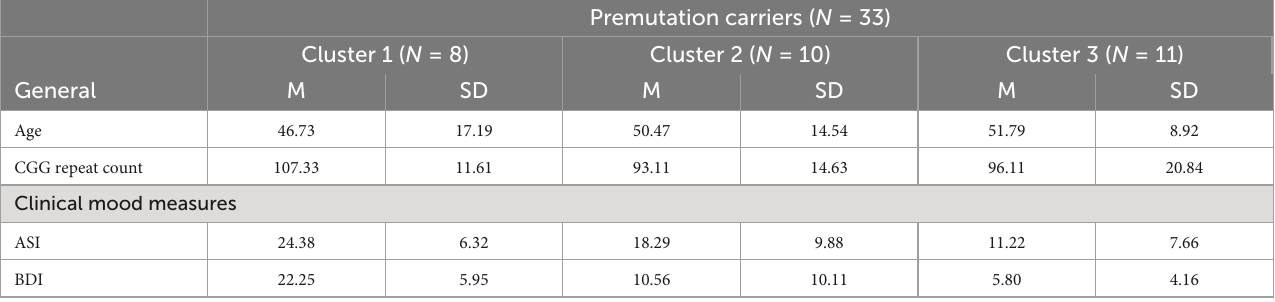
TABLE 1 Participant demographics.